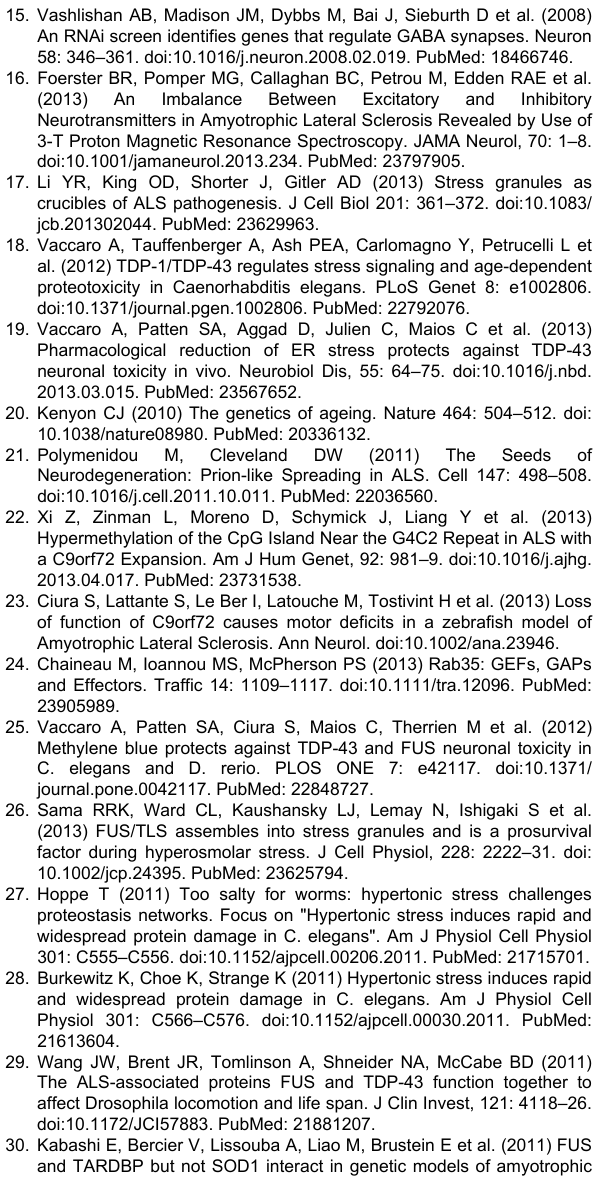
Table S1. Statistics for paralysis tests for all experiments, ns=non